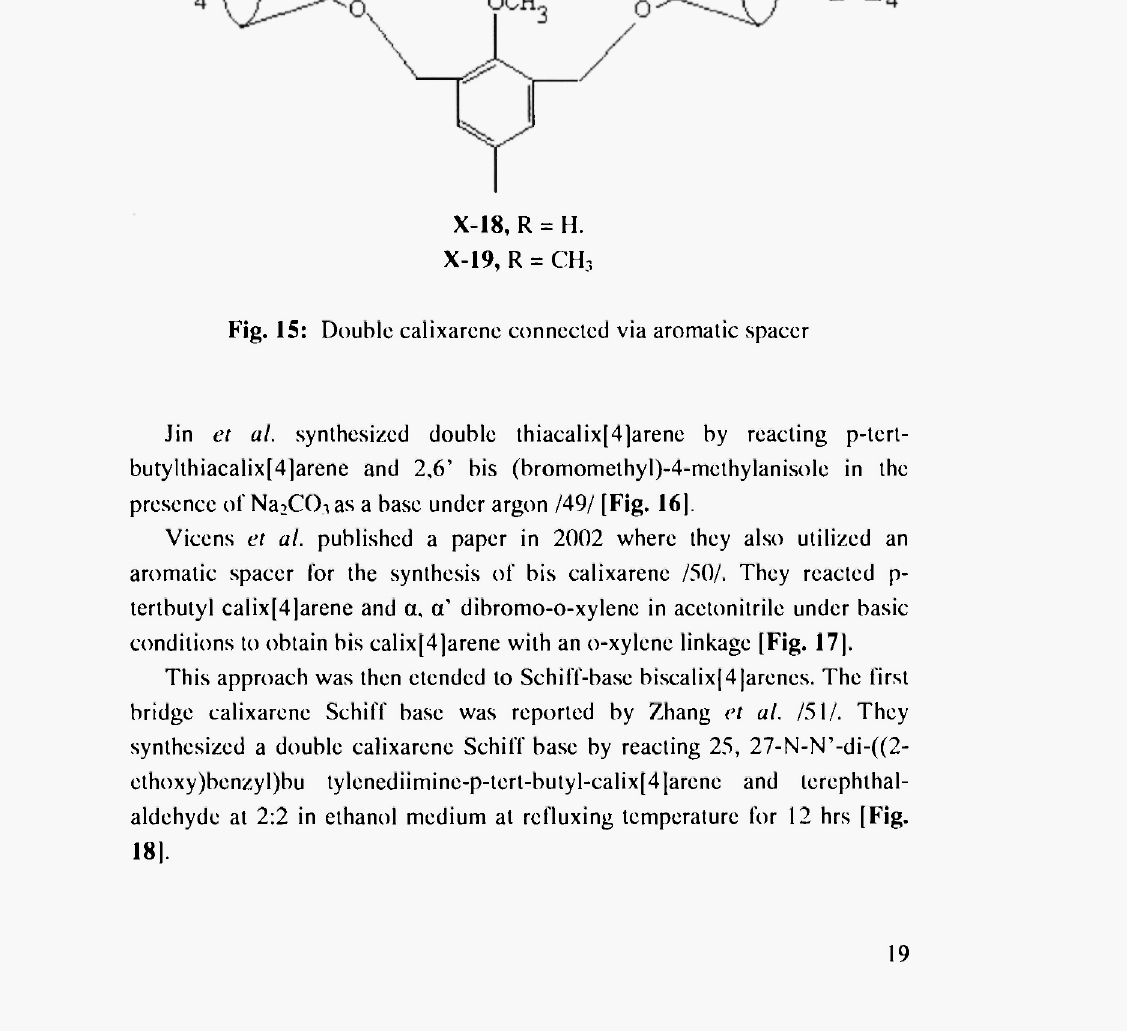
Fig. 15: Double calixarene connected via aromatic spacer